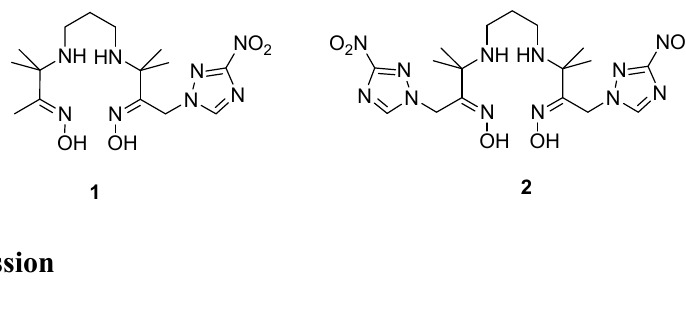
Figure 1. The structure of PnAO complexes 1 and 2